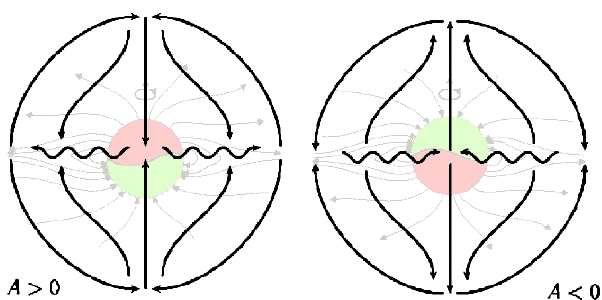
Fig. 1. The drift motion of positively charged cosmic ray particles in the heliosphere for solar cycles with A> 0 (left panel) and A< 0 (right panel). The Sun (not to scale), the solar magnetic field, and its polarity are indicated in the background